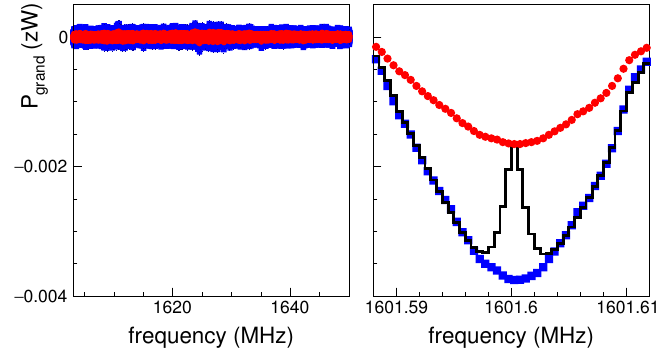
Figure 10 . Rectangles (blue) and circles (red) are the underestimated and scaled background corrections, respectively, obtained from the CAPP-8TB simulation data and background only sim- ulation data. Left and right show the corrections in the frequency regions without and with the simulated axion signals, respectively, and the solid line (black) on the right is the same as the solid line in figure